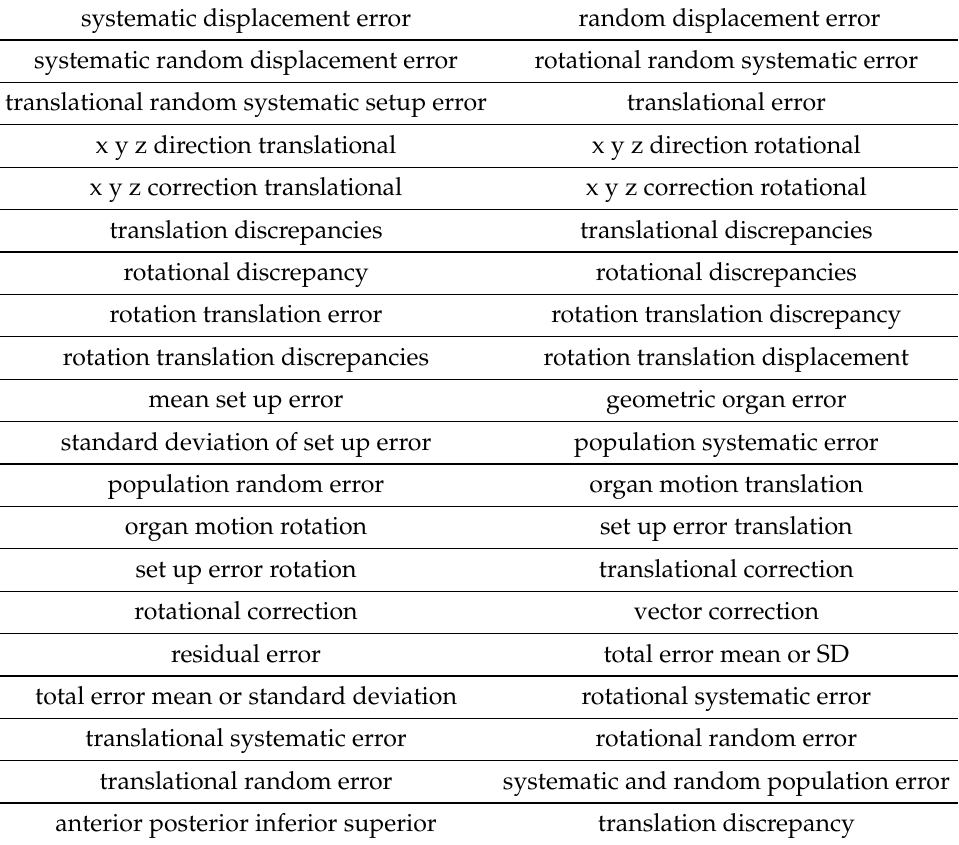
Table 1. Relevant Keywords of Geometric Errors in Radiation